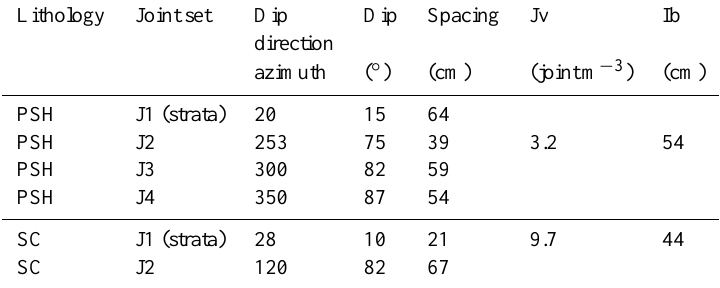
Table 3. Joint parameters from the remote measurements.